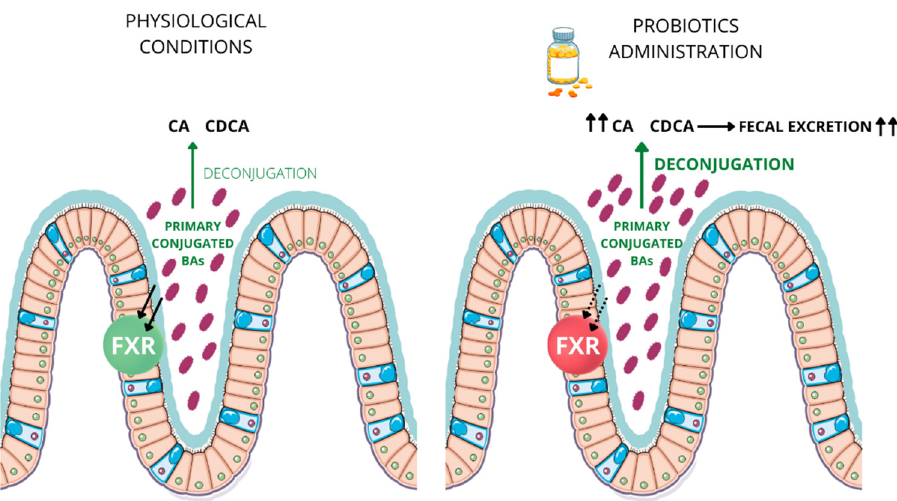
Figure 1. BSH-competent bacteria activity in probiotics. In physiological conditions, there is a balance between the input of conjugated BA taken up in the enterocytes and activating FXR and the unconjugated BA fecal output. Enriching the intestinal milieu with BSH-competent intestinal microorganisms induces BA transformation that, in turn, shapes the magnitude of FXR activation in the enterocytes. This translates into increased fecal BA excretion and lower FXR transcriptional activation. (Bas = bile acids; CA = cholic acid; CDCA = chenodeoxycholic acid; FXR = Farnesoid X Receptors; green FXR indicates activated FXR; red FXR indicated de-activated FXR; purple globus indicates BSH-competent bacteria; black arrows pointing up indicate an increase of CA, CDCA and fecal excretion, bold green arrow pointing up—right panel—indicates increased deconjugation).